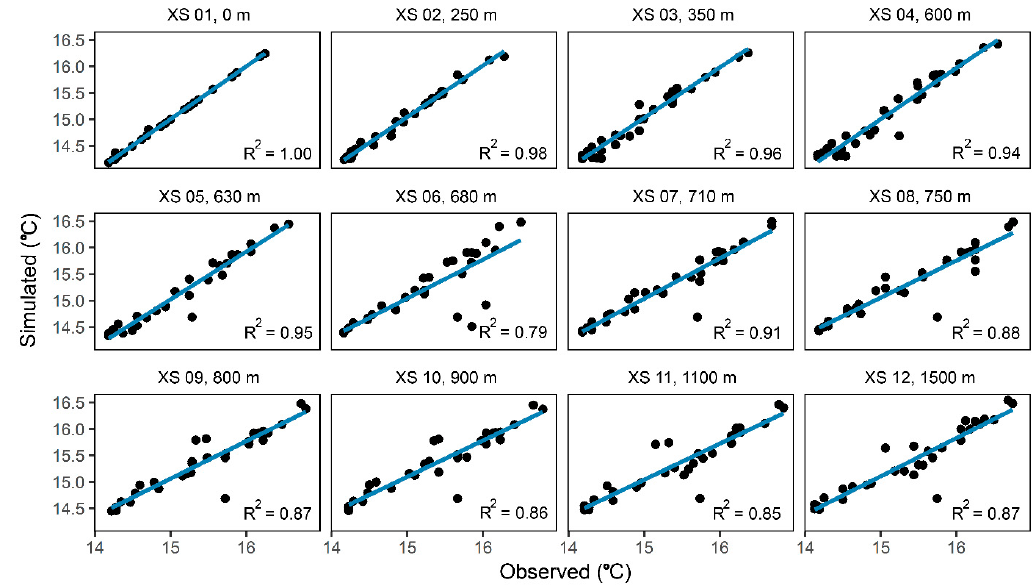
Figure 4. Observed versus simulated river temperatures for the 12 cross sections (XS) and stations from 0 m to 1500 m in Sawmill Creek. The coefficient of determination, R 2 for each cross section is shown in the plot.